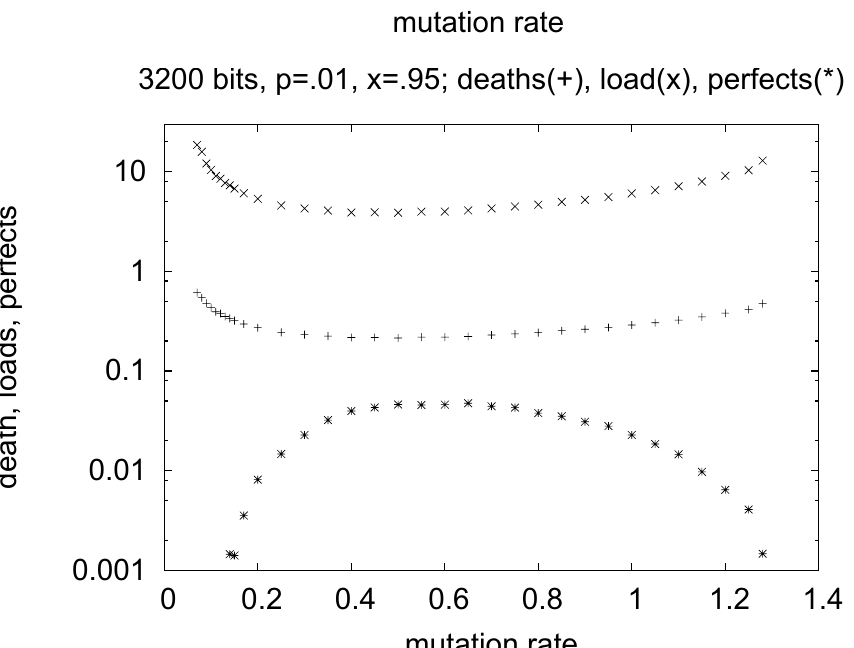
Fig. 4–Averagegeneticload h N i , deathsandnumberofperfectindividualsasafractionofthepopulation. Top figure for bit-strings of size 64, and bottom figure for 3200. Simulations running for 10 6 time